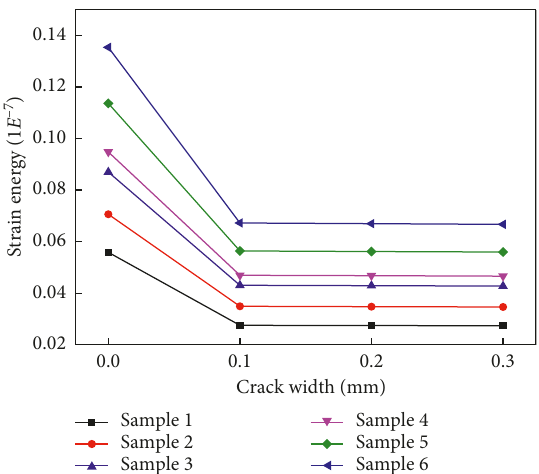
Figure 23: Strain energy of receiver node versus crack width.